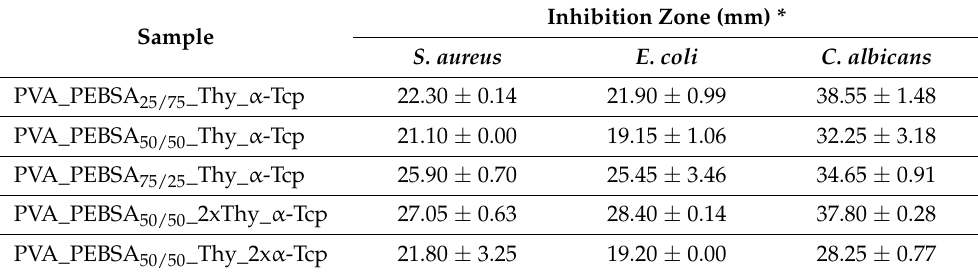
Table 2. Antimicrobial activity (mm) of the tested samples against the reference strains. Sample